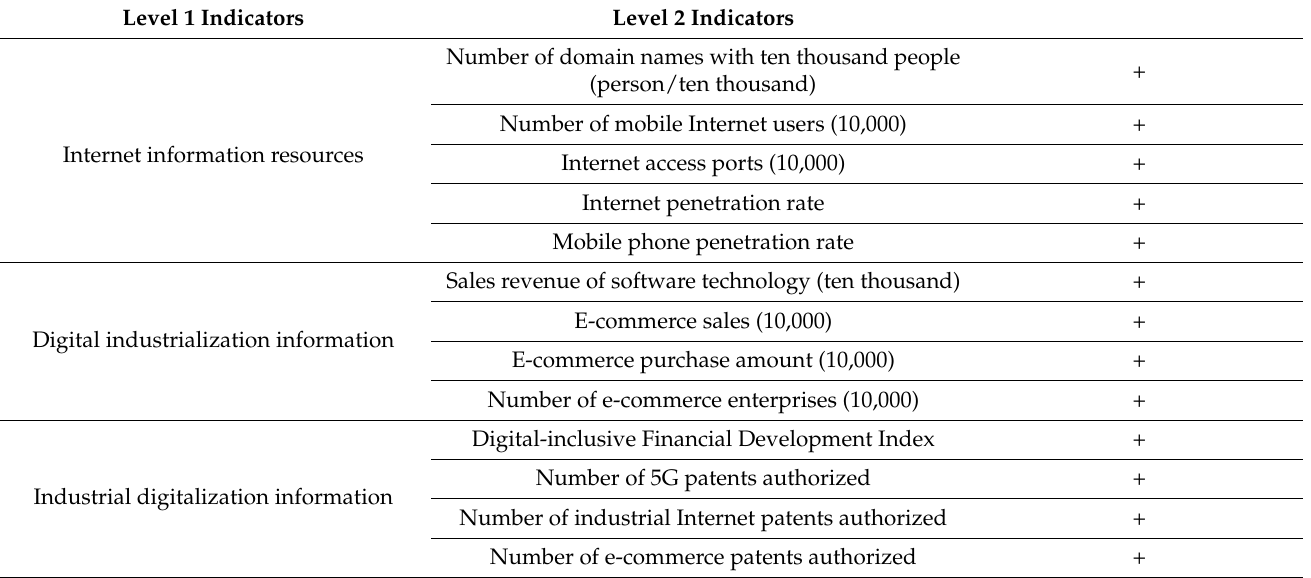
Table 11. Comprehensive index system of information